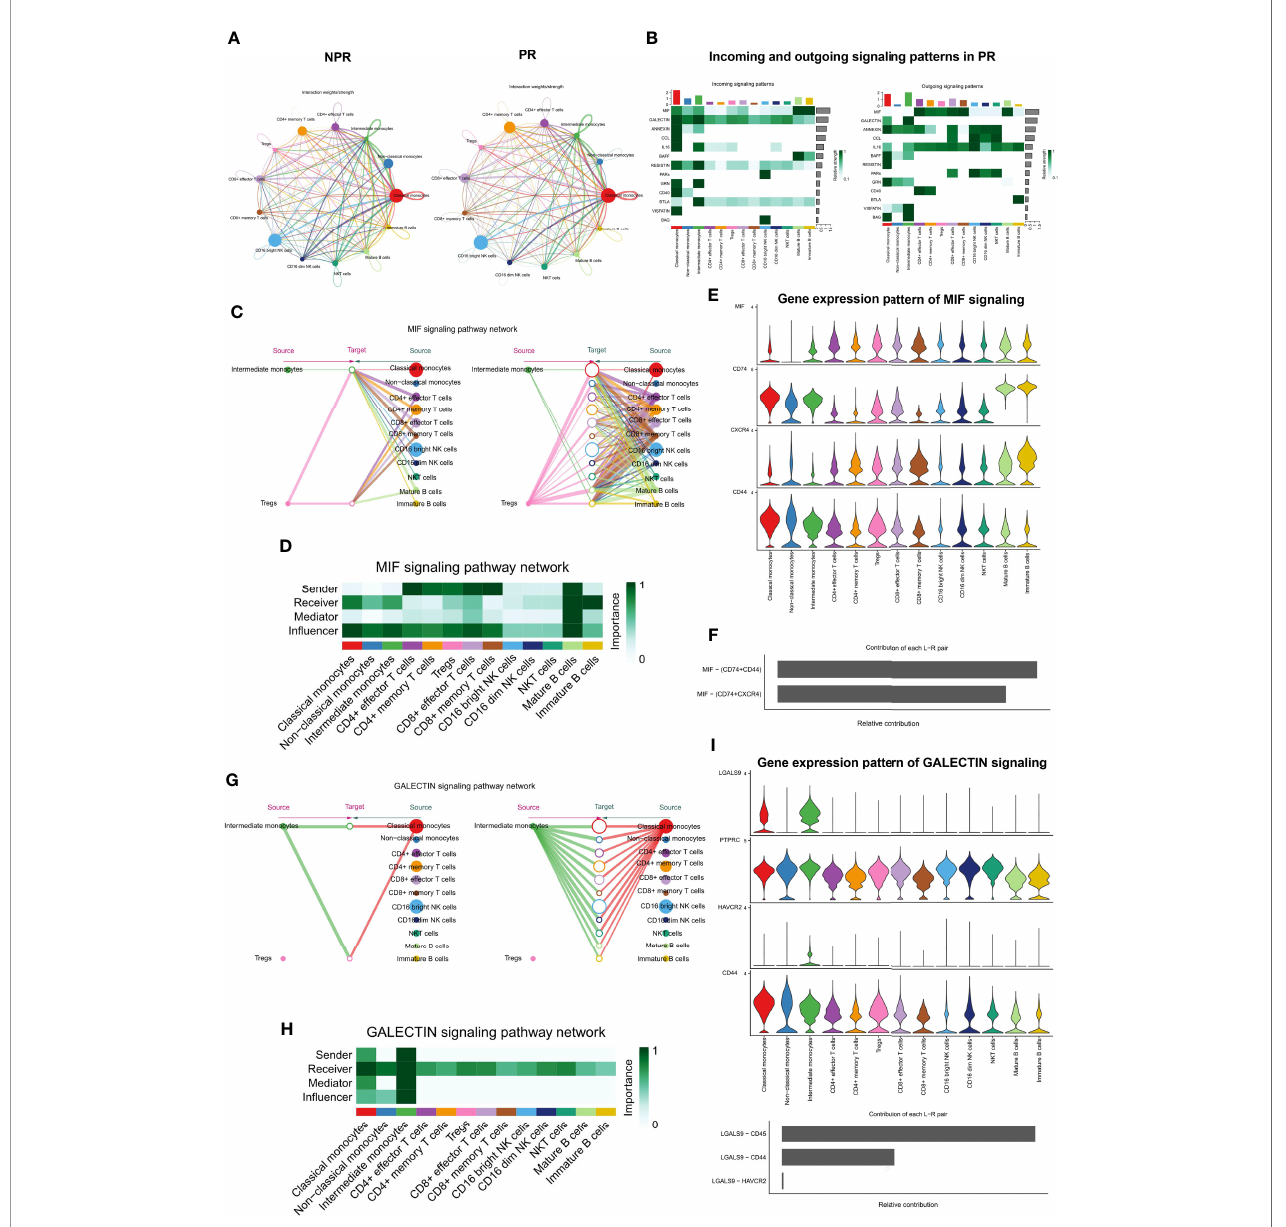
FIGURE 8 | Complex intercellular communication network in the circulating immune cells in patients with AMI. (A) Network visualizing potential speci fi c interactions in patients with PR and NPR, in which nodes are clusters and edges represent the number of signi fi cant ligand – receptor pairs. (B) Incoming and outcoming signaling pattern in patients with PR. (C) Hierarchical plot showing the inferred intercellular communication network for MIF signaling pathway. Left and right portions highlight the autocrine and paracrine signaling to intermediate monocytes, Tregs, and to other monocytes, T cell types, NK, and B cell types, respectively. (D) Heatmap showing the relative importance of each cell group for the four network centrality measures-based MIF signaling network. (E) Violin plot showing the expression distribution of signaling genes involved in the inferred MIF signaling network. (F) Relative contribution of each ligand – receptor pair to the overall communication network of MIF signaling pathway. (G) The inferred GALECTIN signaling pathway network. (H) The computed network centrality measures of GALECTIN signaling. (I) The expression distribution of signaling genes involved in the inferred GALECTIN signaling network. (J) Relative contribution of each GALECTIN ligand – receptor